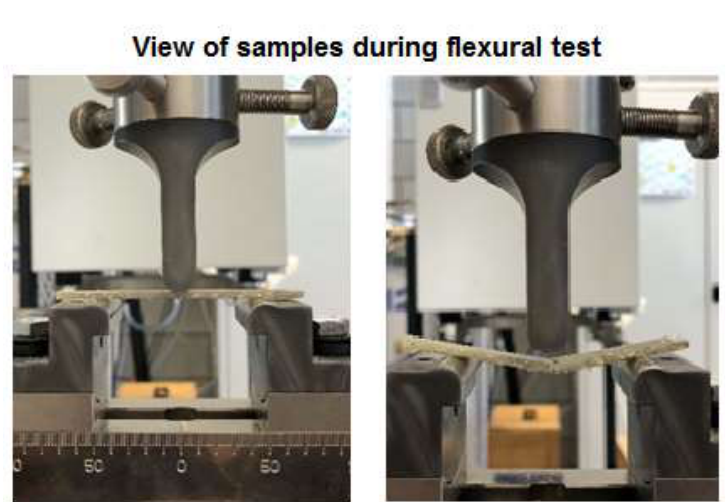
Figure 11. Exemplary samples during the mechanical measurements.